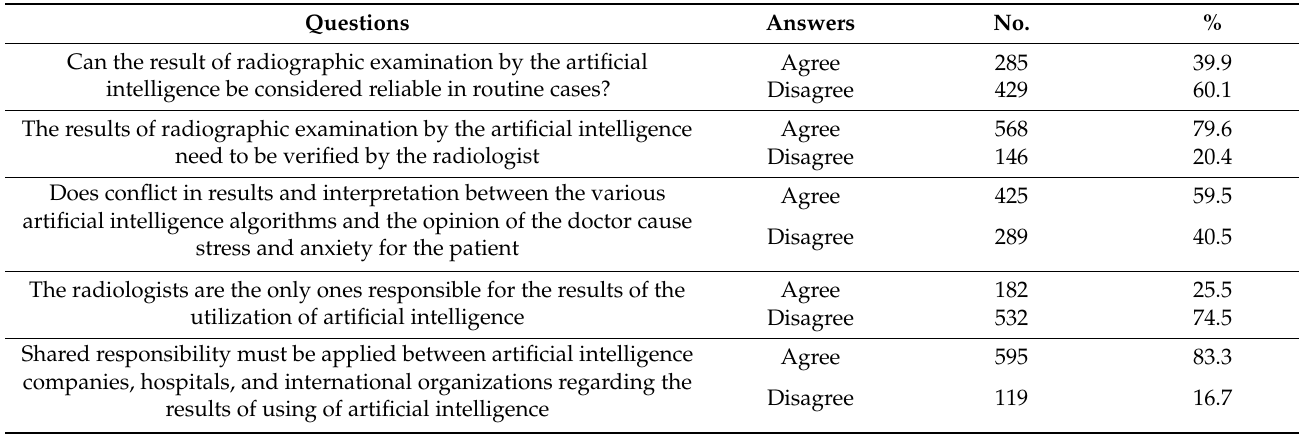
Table 3. Outcomes